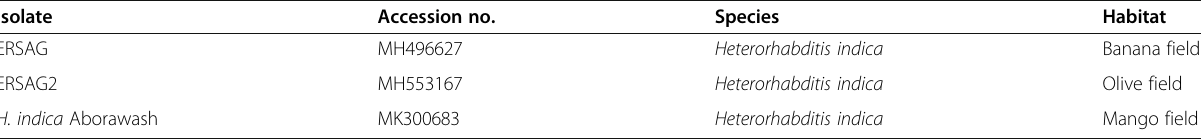
Table 2 Gene bank accession numbers for ITS1-5.8S-ITS2 sequences and the result of their BLAST against the Nucleotide collection (nt) database of the NCBI website Isolate Accession no.